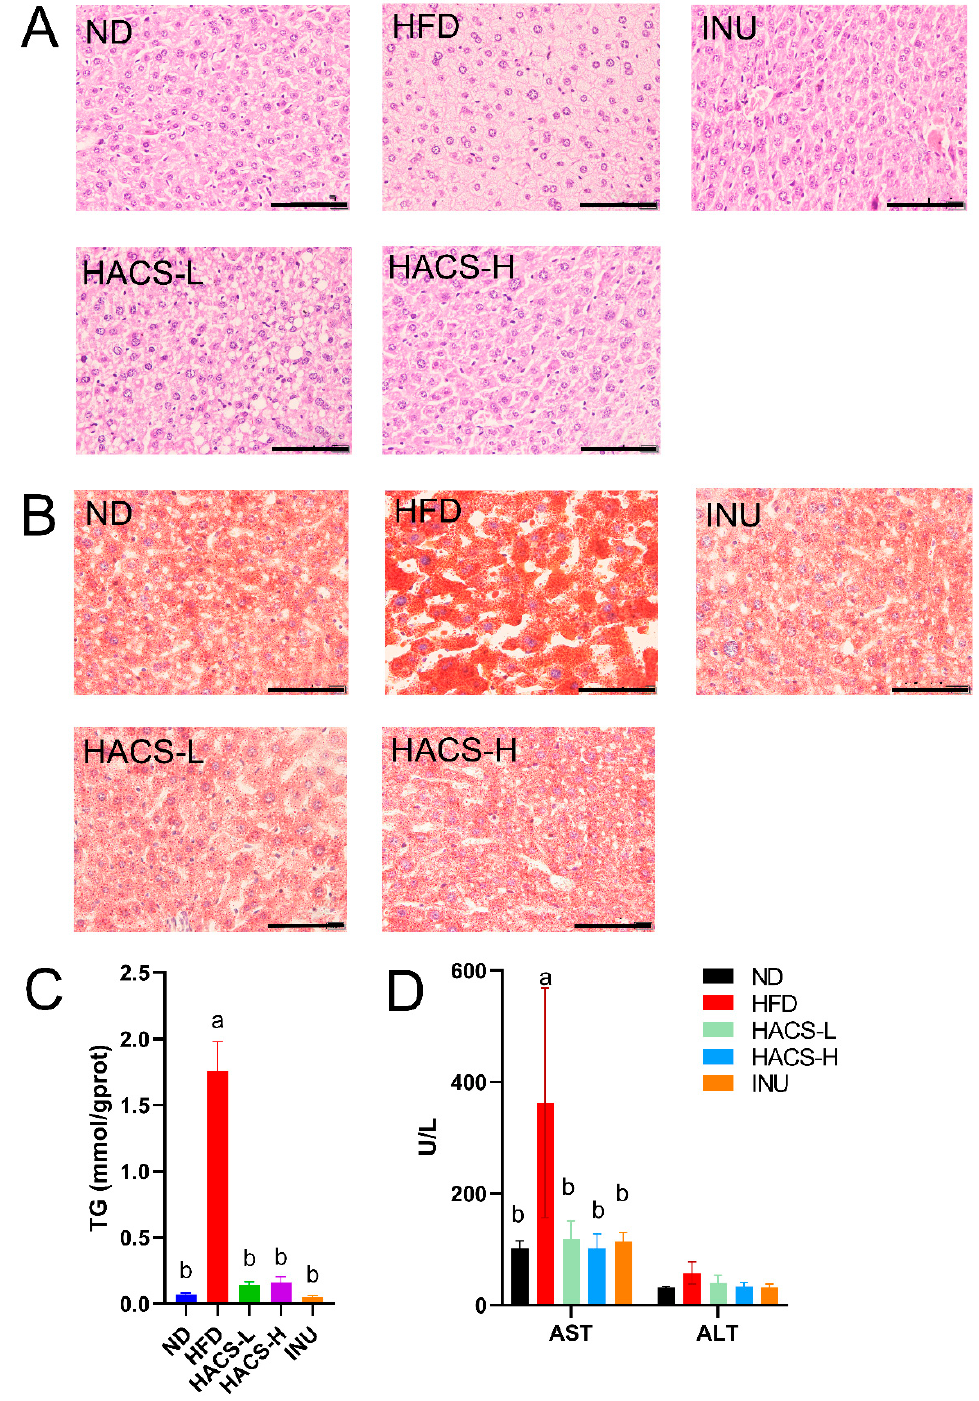
Figure 3. Effects of HACS treatment on liver tissue. HE staining ( A ), Oil Red O staining ( B ), the content of TG ( C ), and the levels of ALT and AST ( D ) of the liver. ND, normal diet; HFD, high fat diet; HACS-L, high fat diet + 0.25 g/kg HACS; HACS-H, high fat diet + 0.5 g/kg HACS; and INU, high fat diet + 0.5 g/kg inulin. Data were expressed as the mean ± SD ( n = 5 per group). Different lowercase letters represent significant differences ( p < 0.05), and the same lowercase letters represent no significant differences ( p ≥ 0.05). The scale bars represent 100 μ m.